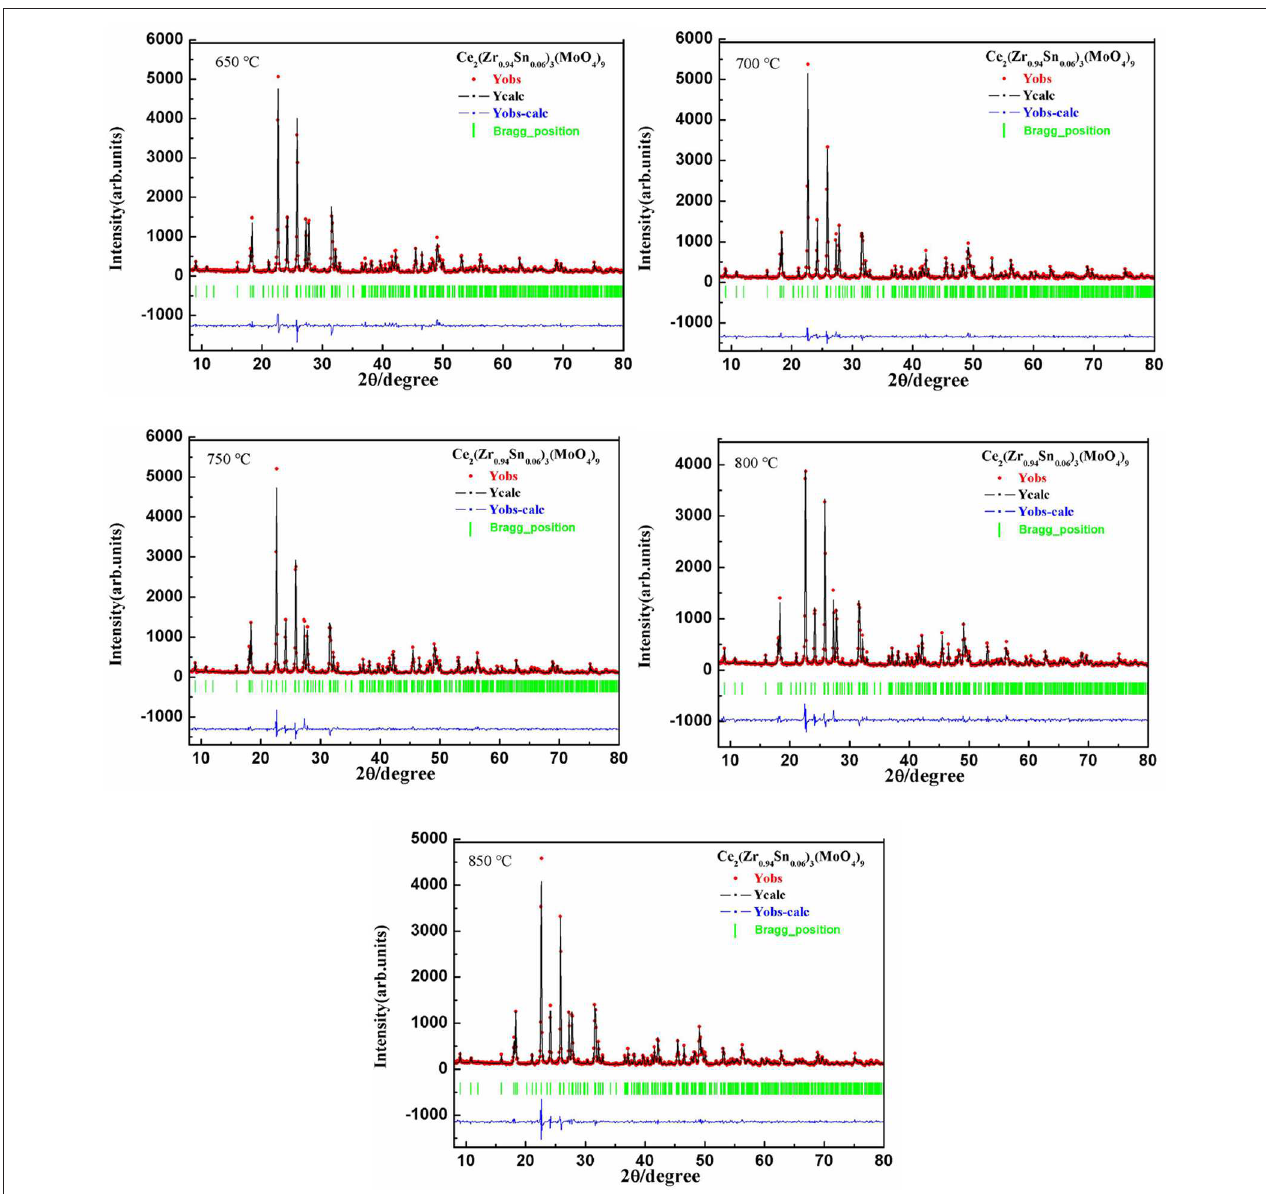
FIGURE 2 | Rietveld refinement of Ce 2 (Zr 0.94 Sn 0.06 ) 3 (MoO 4 ) 9 ceramics sintered at 650–850 ◦